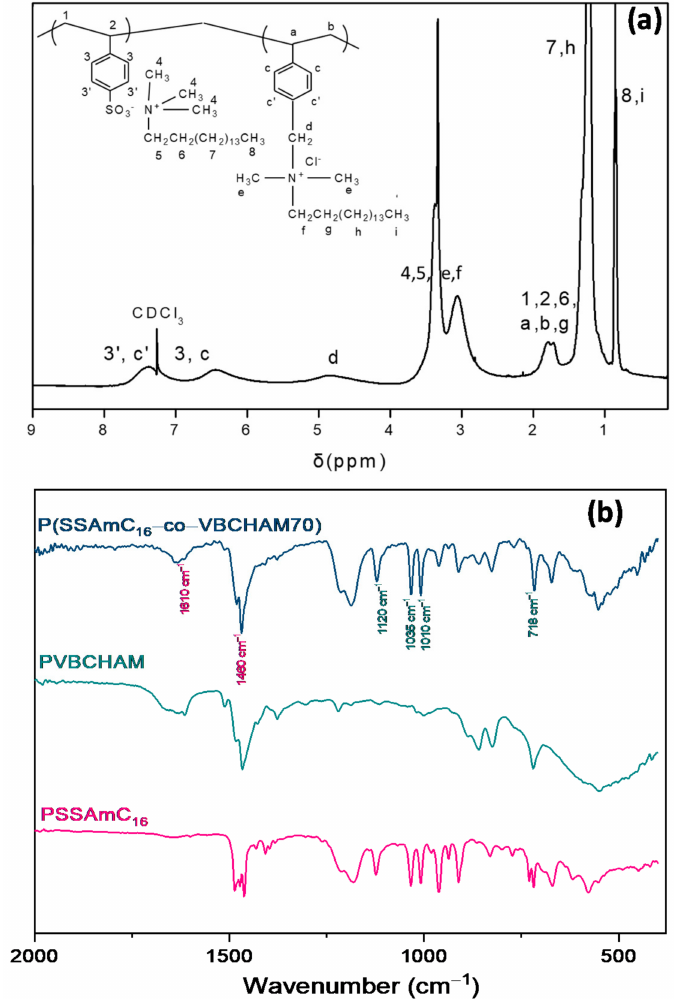
Figure 1. ( a ) The 1 H-NMR and ( b ) ATR-FTIR spectra of the copolymer P(SSAmC 16